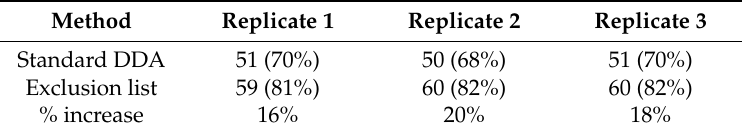
Table 1. Number of RNase T1 digestion products identified (and percentage out of 73 predicted) from Escherichia coli total tRNA via replicate runs of standard Data Dependent Acquisition-based LC-MS/MS and LC-MS/MS using an exclusion list. Adapted from [59] with